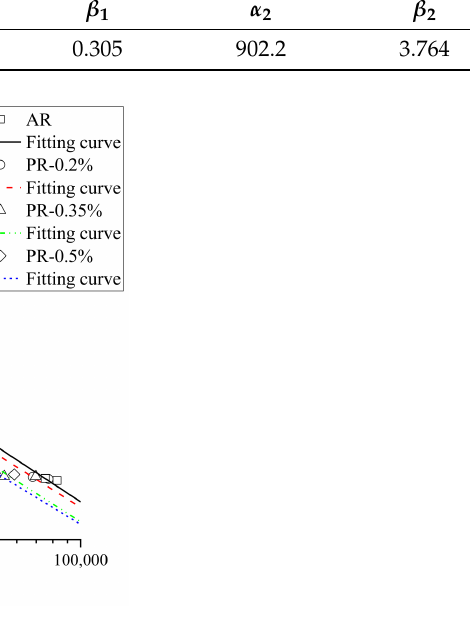
fatigue life with an error factor of two. All data were in the region between the two dashed lines. The results indicated that the model could describe the effect of the pre-strain on the fatigue properties of welded joints very well.